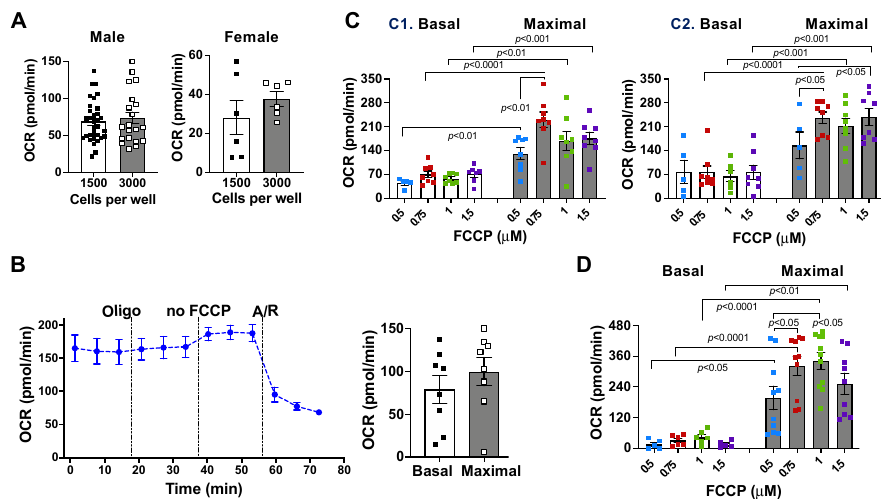
Supplemental Figure S1A,B. Cardiomyocytes were detected instantly prior to the assay (Supplemental Figure S1C).